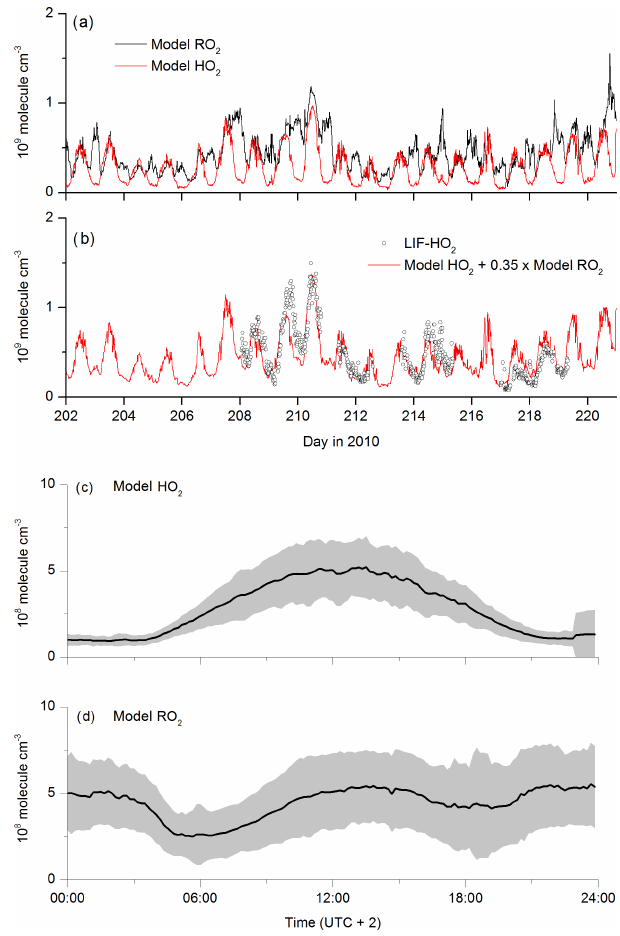
Figure 9. Modelled HO 2 and RO 2 concentrations as time series (a) and campaign-averaged diel profiles (c, d) . RO ∗ peroxy radicals formed in the OH-initiated degradation of OVOCs and terpenes. The red line in plot (b) is the sum of model HO 2 concentration plus 0.35 times the model RO 2 concentration.